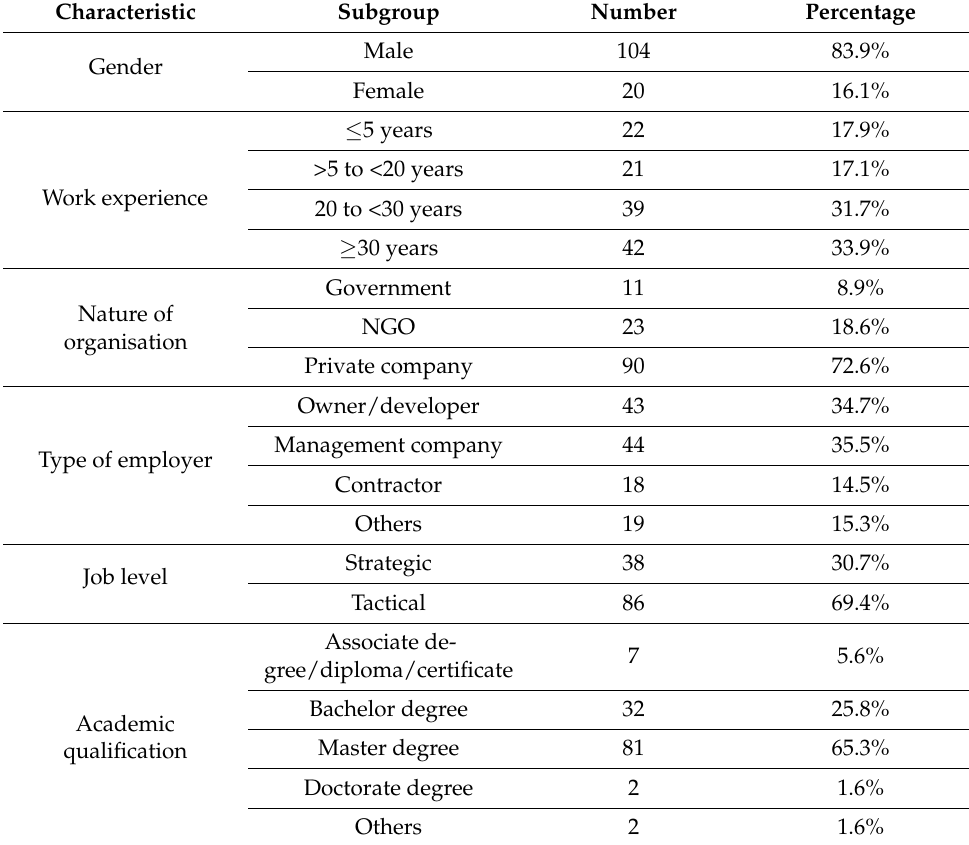
Table 2. Demographic details of